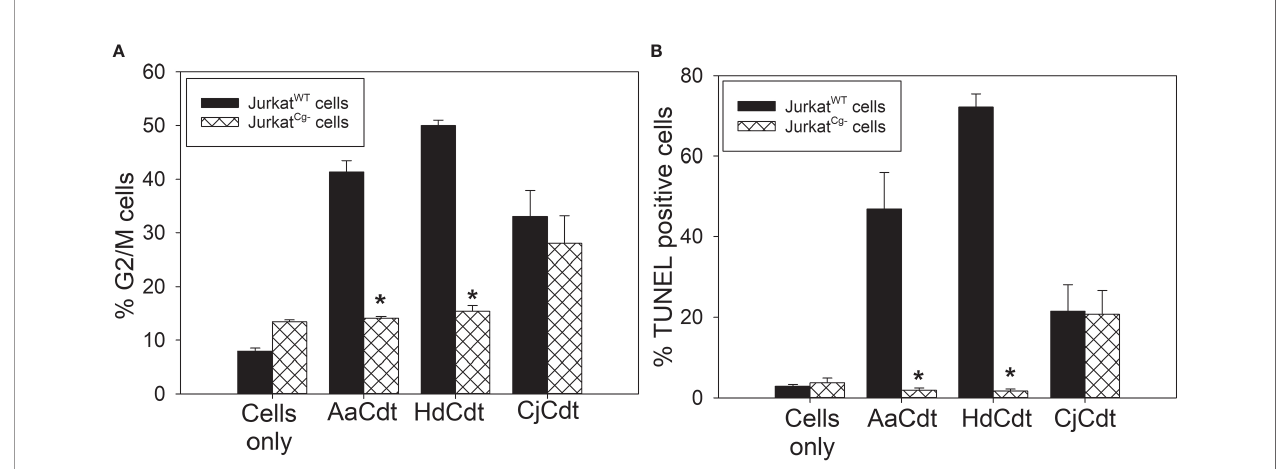
FIGURE 6 | Comparison of HdCdt and CjCdt for the requirement of the host cell protein cellugyrin to elicit toxicity. (A) Jurkat WT (solid bars) and Jurkat Cg- (cross- hatched bars) cells were treated with AaCdt, HdCdt, and CjCdt as described above for 16 hr and then assessed for cell cycle distribution. Results show the percentage of cells in the G2/M phases of the cell cycle and are plotted as mean ± SEM of three experiments. (B) Jurkat WT (solid bars) and Jurkat Cg- (cross-hatched bars) cells were treated with AaCdt, HdCdt, and CjCdt for 48 hr and analyzed to determine the percentage of apoptotic cells using the TUNEL assay; results are plotted as the mean ± SEM of three experiments. *indicates statistical signi fi cance (p < 0.01) when compared to Jurkat WT